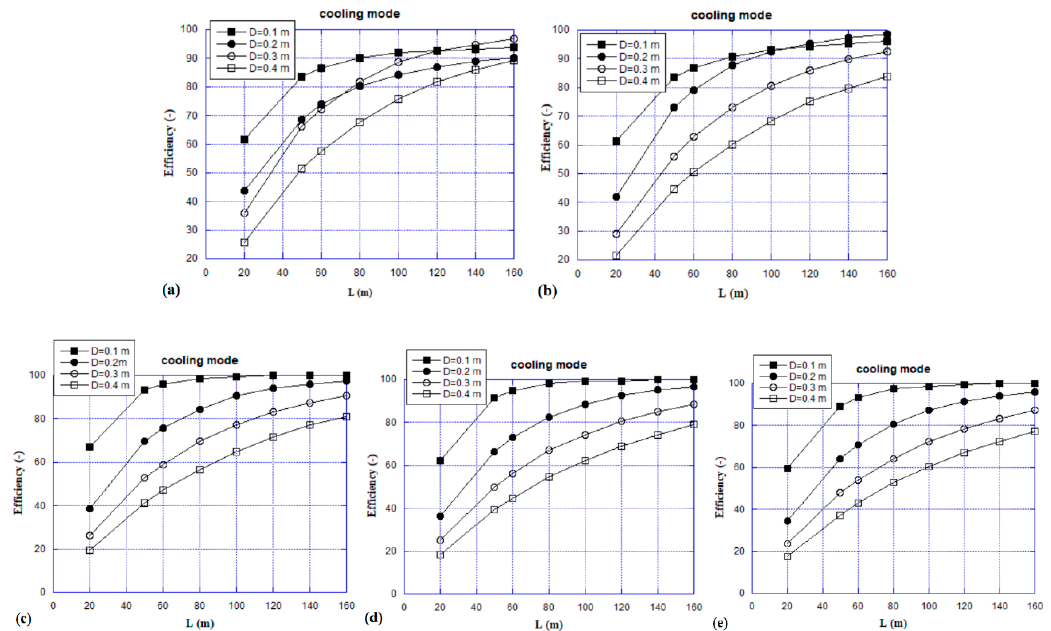
Figure 4. Efficiency of the EAHX vs. pipe length parametrized for diameter for different air velocities at inlet of the pipe: ( a ) 0.5 m s − 1 ; ( b ) 1.0 m s − 1 ; ( c ) 1.5 m s − 1 ; ( d ) 2.0 m s − 1 ; ( e ) 2.5 m s − 1 .